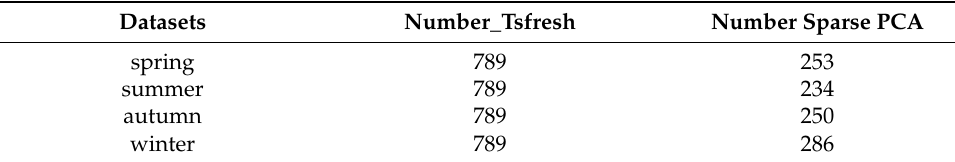
Table 2. Mathematical statistics of the four types of data.